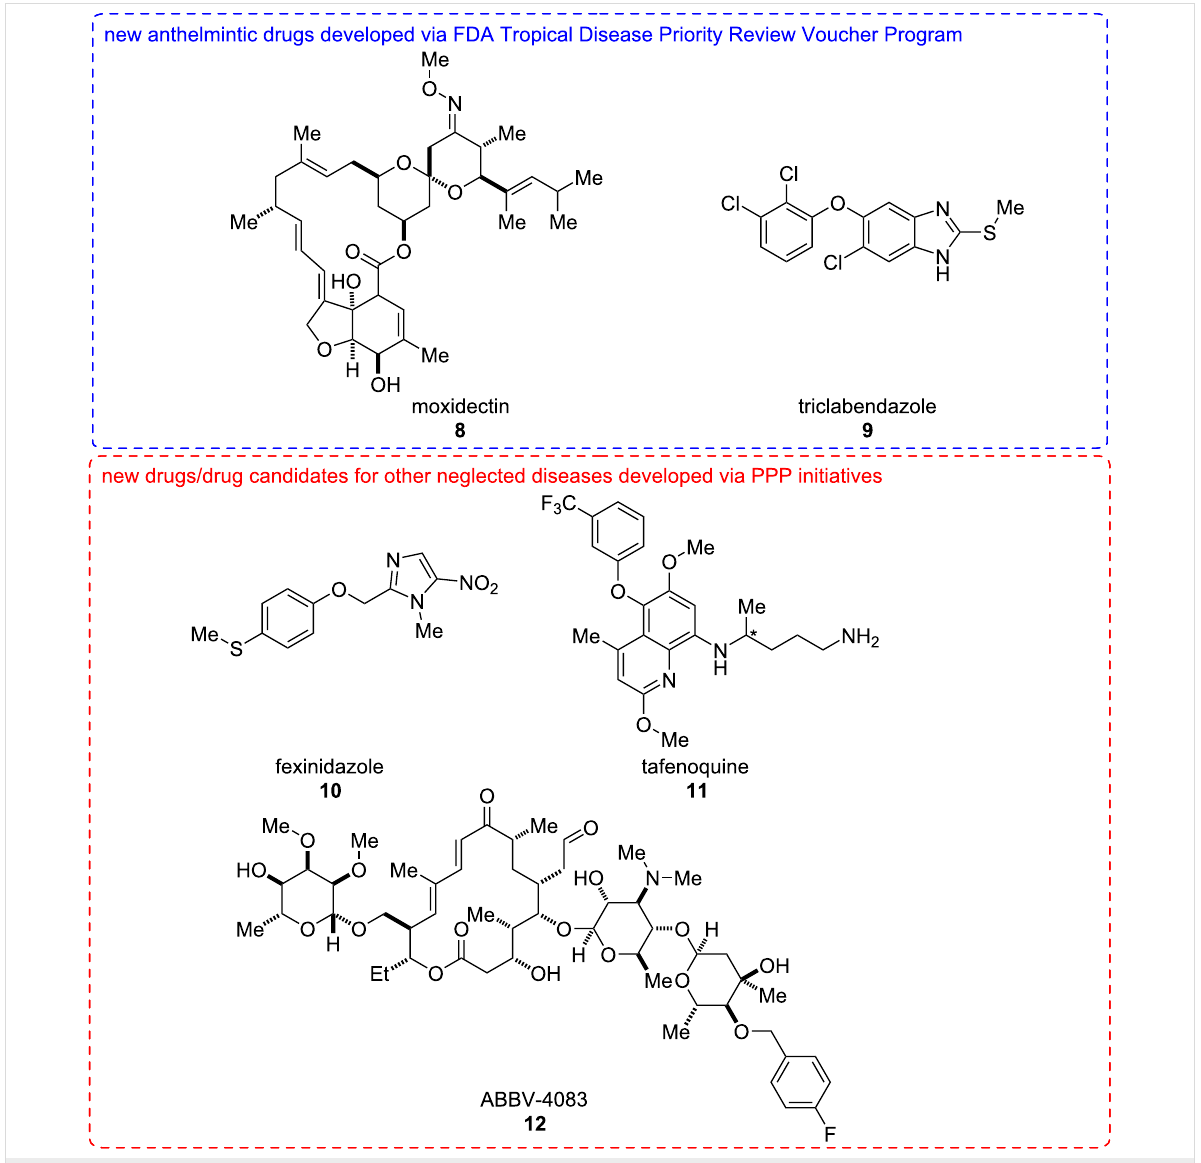
Figure 2: Structures of new anthelmintics drugs developed through repurposing, and new drugs or drug candidates for other neglected diseases de- veloped through public–private-partnership (PPP) initiatives. *Denotes the stereogenic centre: tafenoquine ( 11 ) is administered as a racemic mixture.